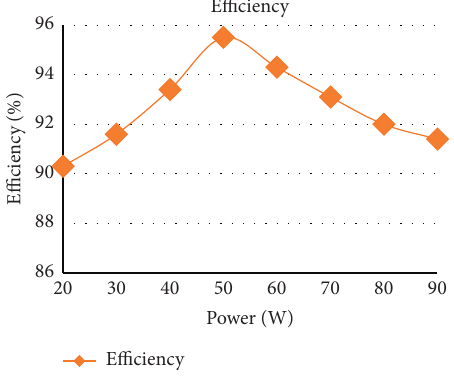
Figure 22: Efficiency curve of the